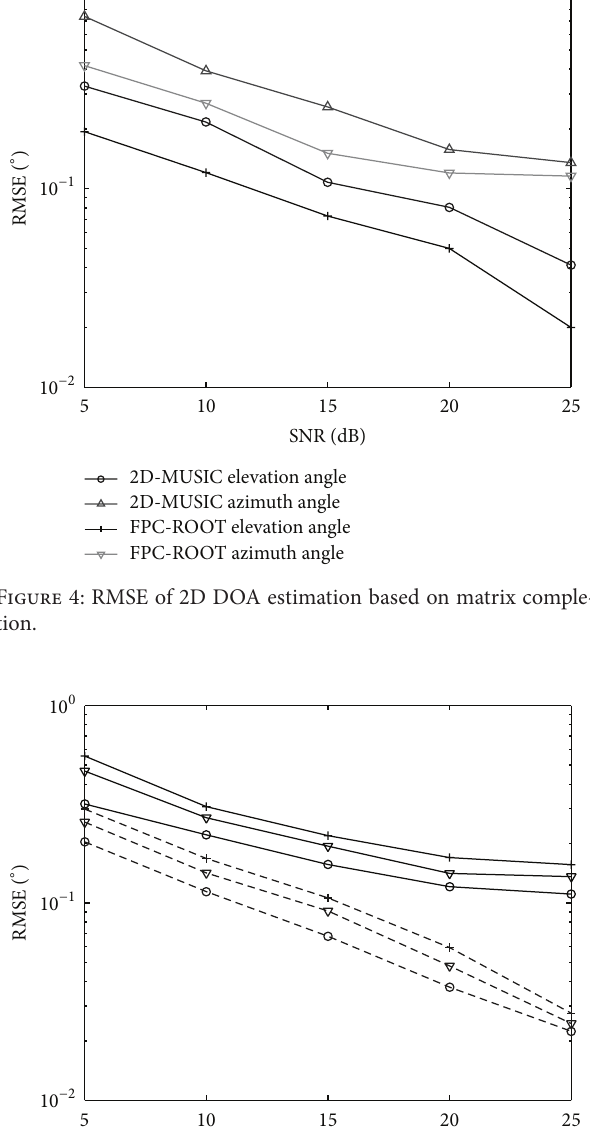
Figure 3: Recovery errors by matrix completion with different elements and SNR.